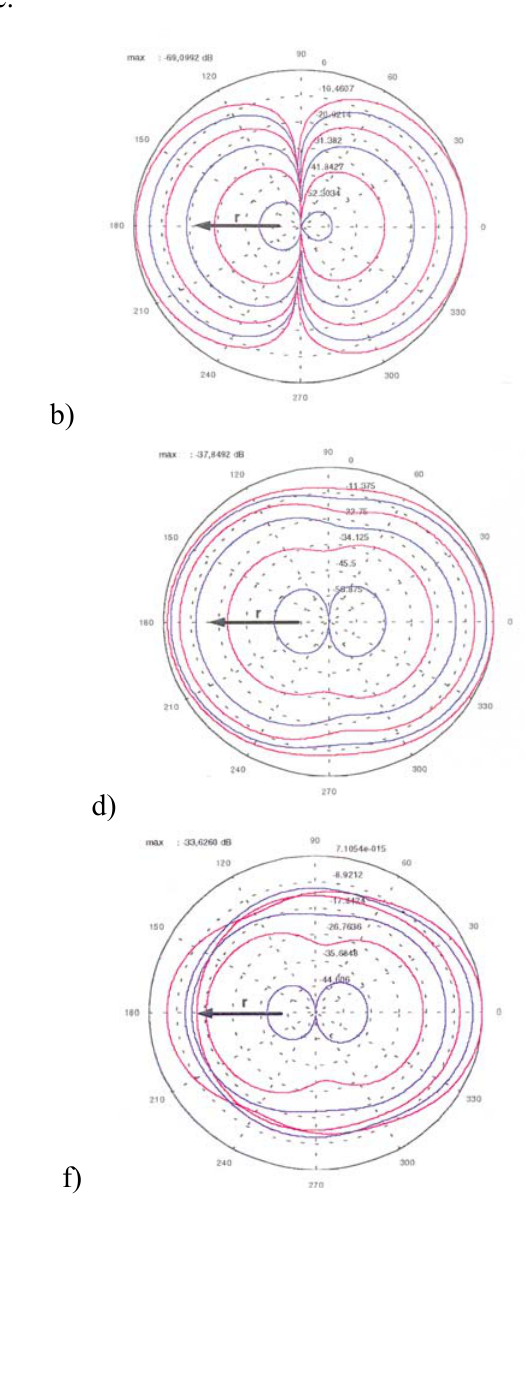
Figure 3. Scattering power patterns in the XZ plane for incidence from Z-direction (indicated by the arrow) at X-polarization, and different equivolumetric drop radii from 0.5 (inner curves) to 3.0 mm (outer curves) and frequencies: a) 1.4 GHz, b) 2.56 GHz, c) 10.68 GHz, d) 19.0 GHz, e) 22.0 GHz, f) 37.0 GHz, and g) 94.0 GHz. Plots normalized and in decibels, maximum value shown in each